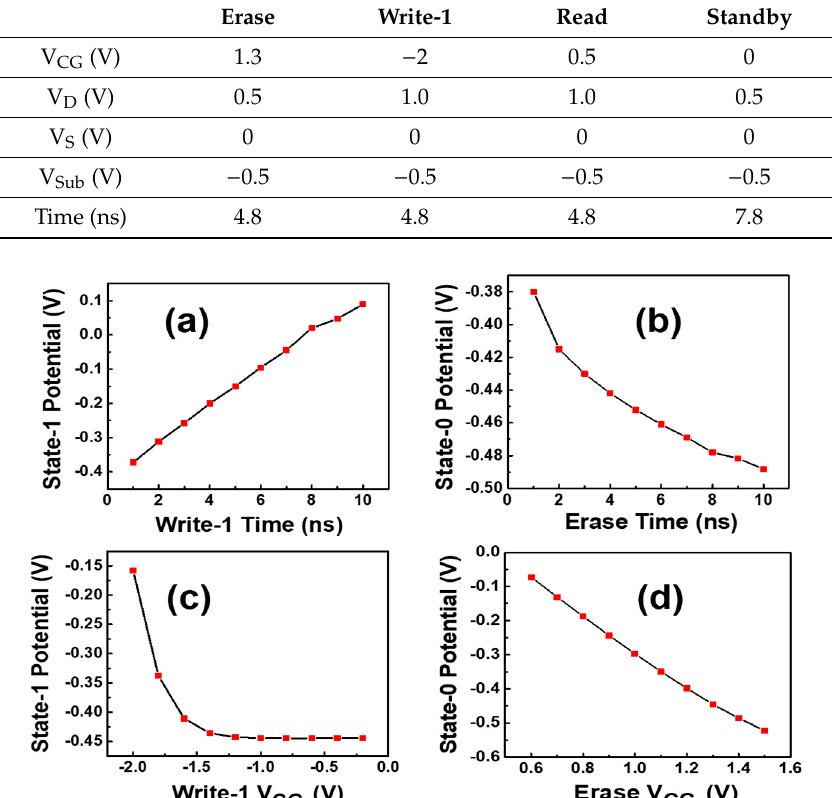
Table 1. Time and operation voltage of the SFG transistor on the SOI. Erase Write-1 Read Standby